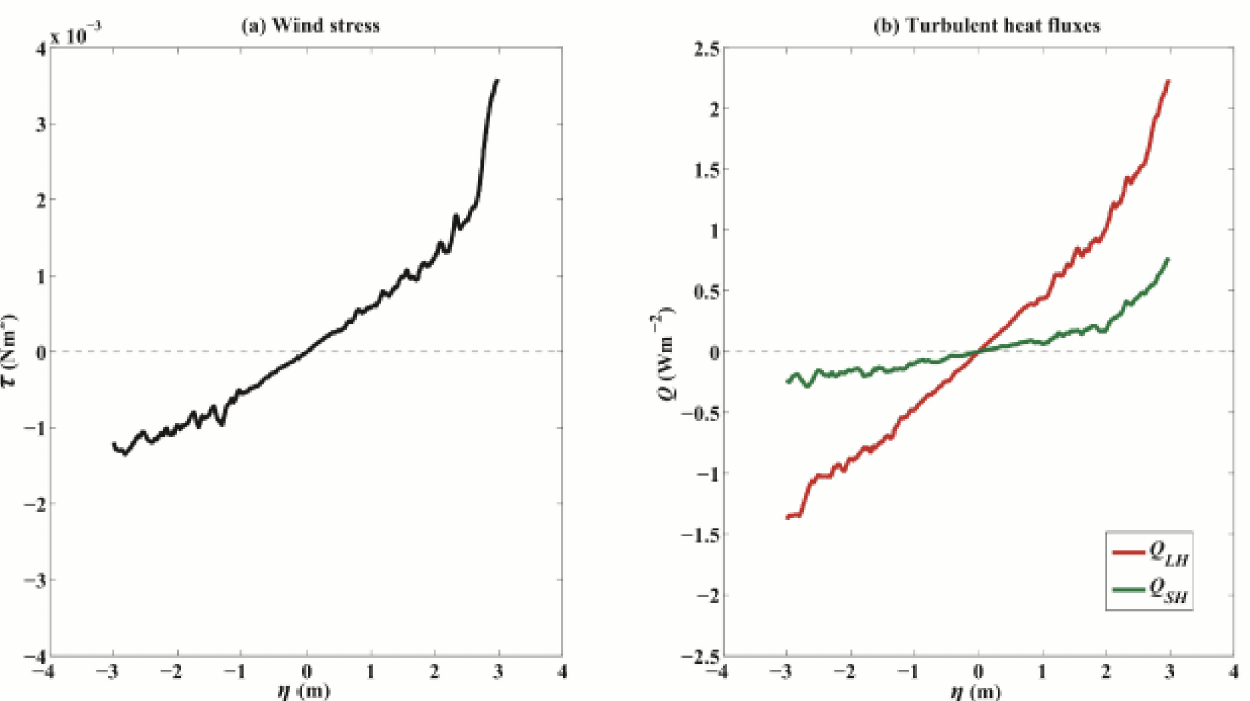
Figure 7. ( a ) Wind stress differences with variations in the magnitude of SSE ( x-axis ) based on two-year observations. ( b ) is the same as ( a ) but for Q LH (unit: Wm − 2 ) and Q SH (unit: Wm − 2 ), respectively. Note that the results in ( a ) and ( c ) are the temperature mean results (x-axis mean) of Figure